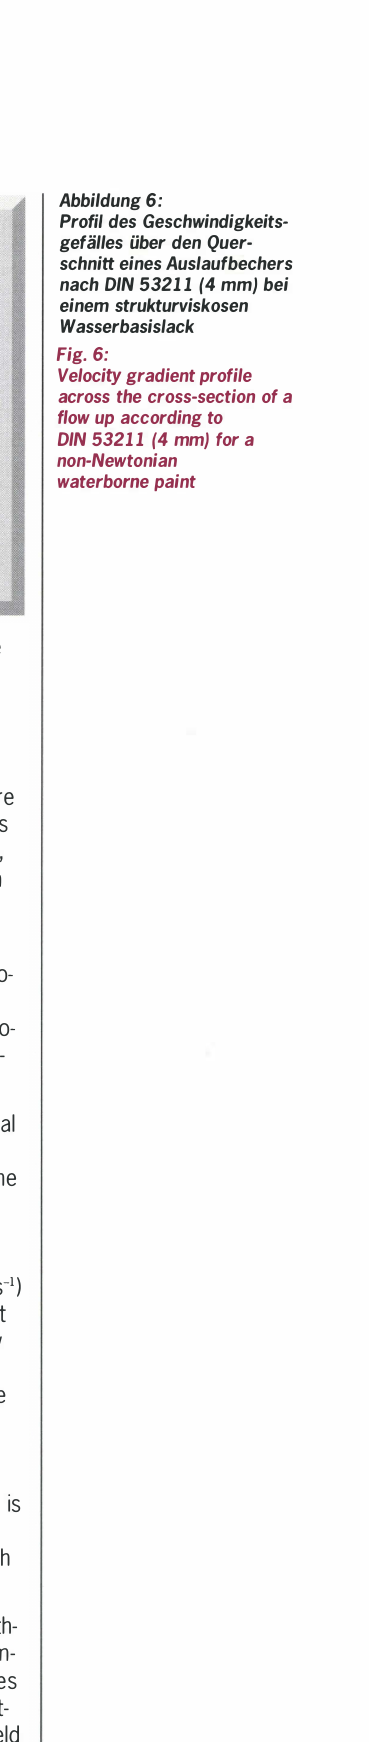
Fig. 5: Flow rate profile of a waterborne paint across the nozzle cross-section of a flow cup according to DIN 53211 (4mm) for an exponential of n = 0.5 at maximum volume throughput (at the start of the determination)